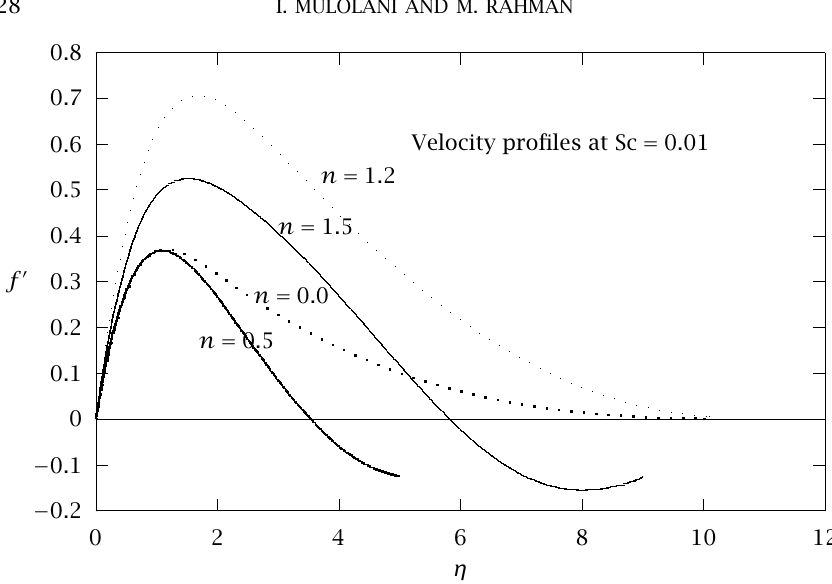
Figure 5.2 . Effect of rate of reaction on velocity.